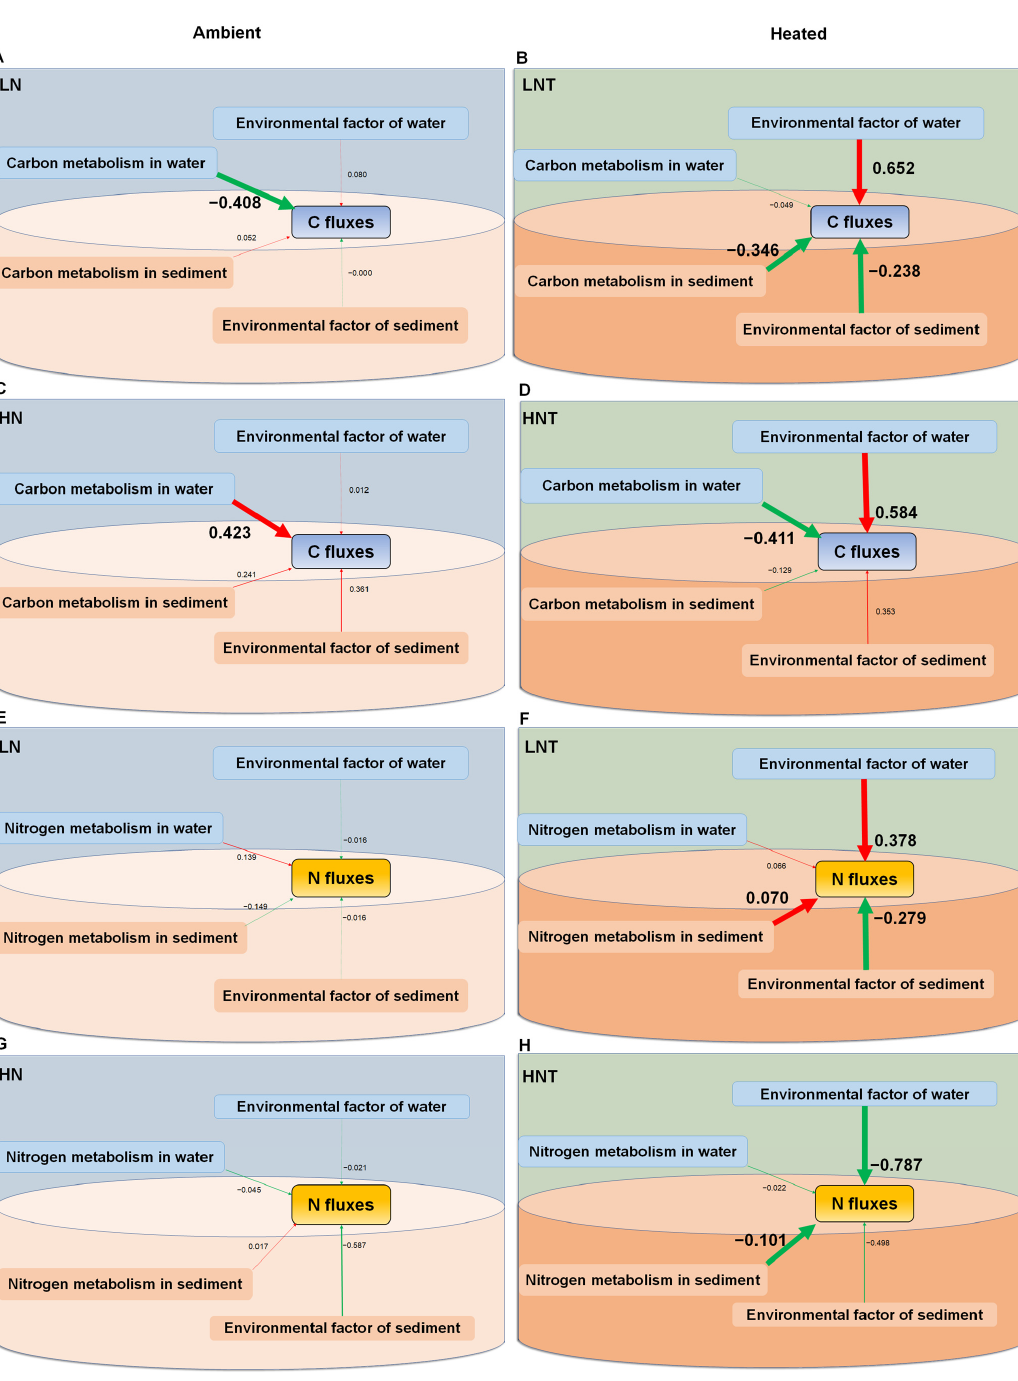
Figure 3. Structural equation models (SEM) showing the effects of nutrient loading and the environmental factor of water (TN w , TP w , and chl a -W) and sediment (TN s , TP s , and TOC) and the metabolism of microbial community (community diversity and functional gene), turbidity (Turb), and their interactions at the end of the experiment under ambient temperatures ( A , C , E , G ), continuous warming by +4.5 ◦ C ( B , D , F , H ). Coefficients of determination (r 2 ) are shown for all endogenous variables. Significant positive and negative effects, and insignificant interactions among variables are depicted in red and green arrows, respectively. Solid arrow thicknesses are proportional to the strength of the relationship. Numbers adjacent to arrows are standardized path coefficients and indicative of the effect of the